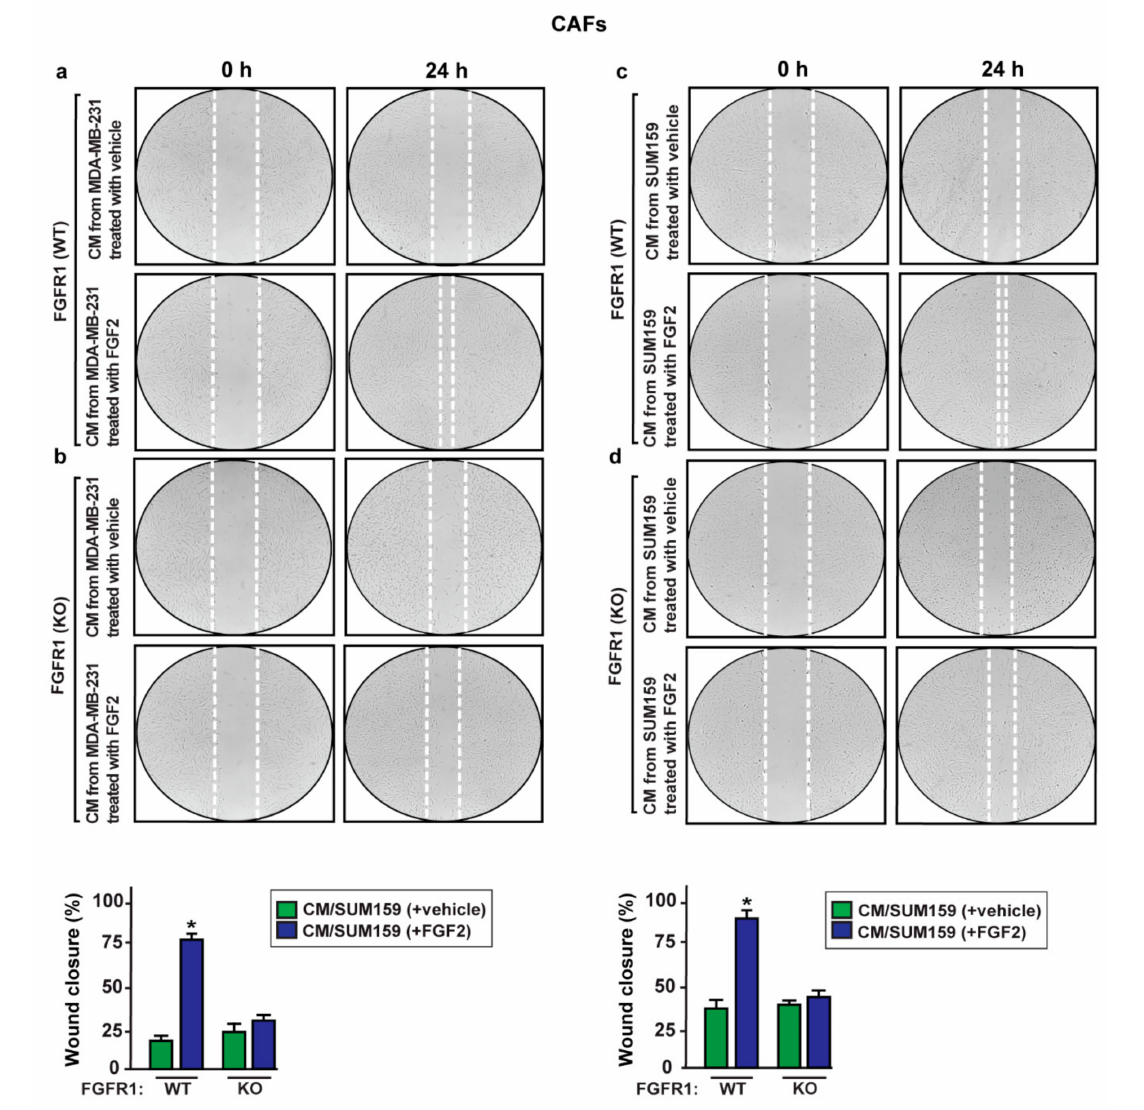
Figure 9. Conditioned medium (CM) from FGF2-stimulated MDA-MB-231 and SUM159 cells induces the migration of CAFs. CAFs were incubated for 24 h with CM collected from FGFR1 (WT) and FGFR1 (KO) MDA-MB-231 ( a , b ) and SUM159 ( c , d ) cells treated for 8 h with vehicle and 25 nM FGF2. Images were acquired at 0 and 24 h after scratching. Quantification of cell migration was expressed as % of wound closure. Data shown are the mean ± SD of three independent experiments performed in triplicate. (*) indicates p <